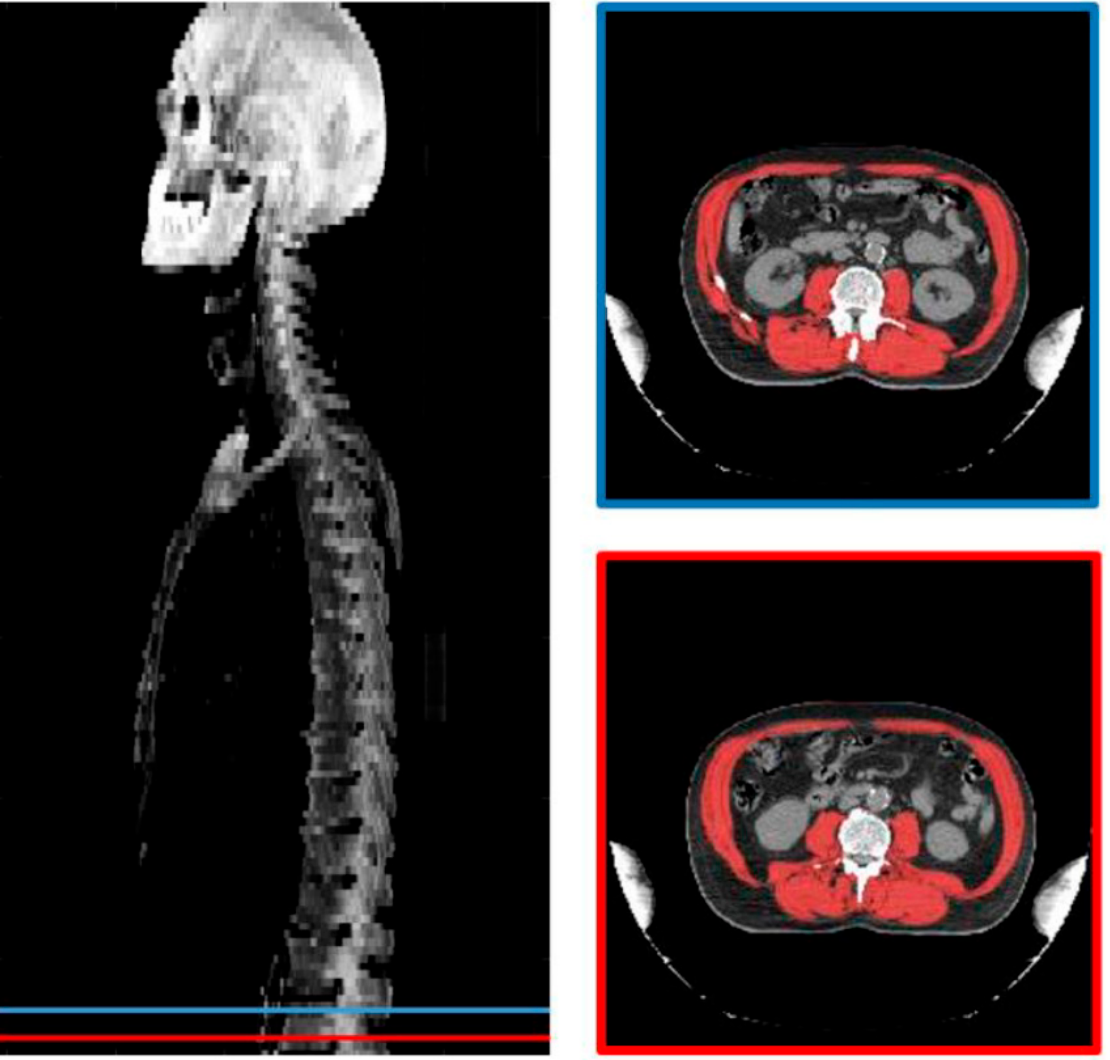
Figure 1. ( Left ) coronal (Maximum Intensity Projection) MIP centered on the vertebral column and the 2 slices selected at the L3 level; ( right ) axial CT slices selected and the segmentation of the skeletal muscles.